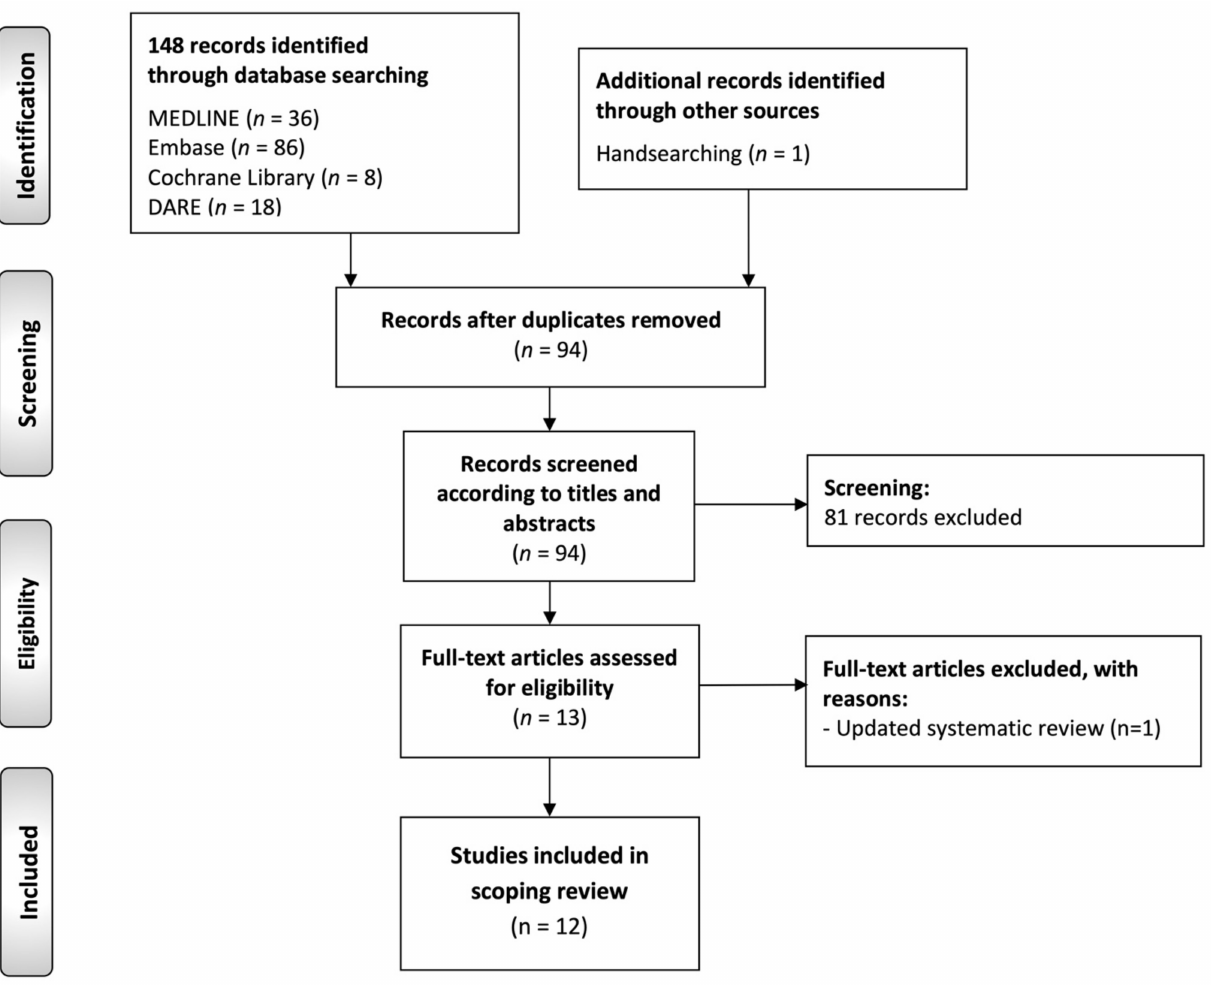
Figure 1. Flow diagram of the identification and selection process of the studies included in this scoping review of systematic